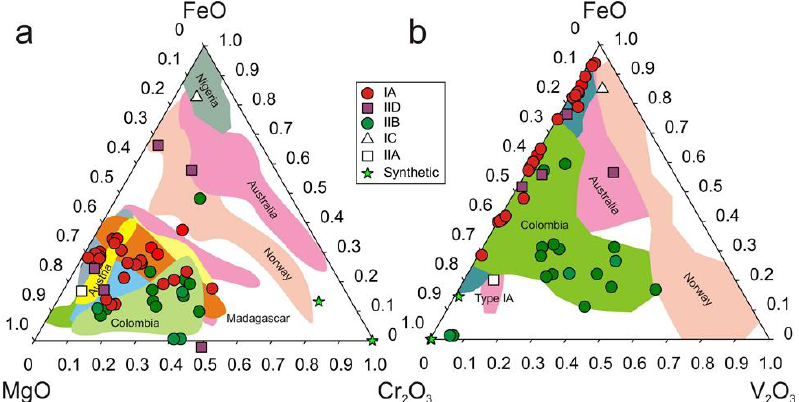
Figure 3. ( a ) Simplified systematic classification for emeralds (modified after [10] ; ( b ) magnesium – Fe – Cr ( a ) and Cr – Fe – V ( b ) ternary diagrams for global emerald deposits. Data for ‘pure emerald’ from this study are shown as symbols and published ranges of data are shown as shaded regions. Previously published data sources are given Tables S4 and S5.